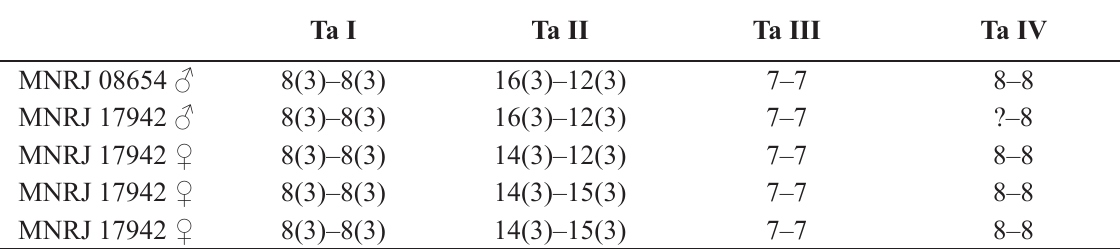
Table 4. Tarsal formula of Phalangodus cottus sp. nov. (numbers in parentheses are the number of